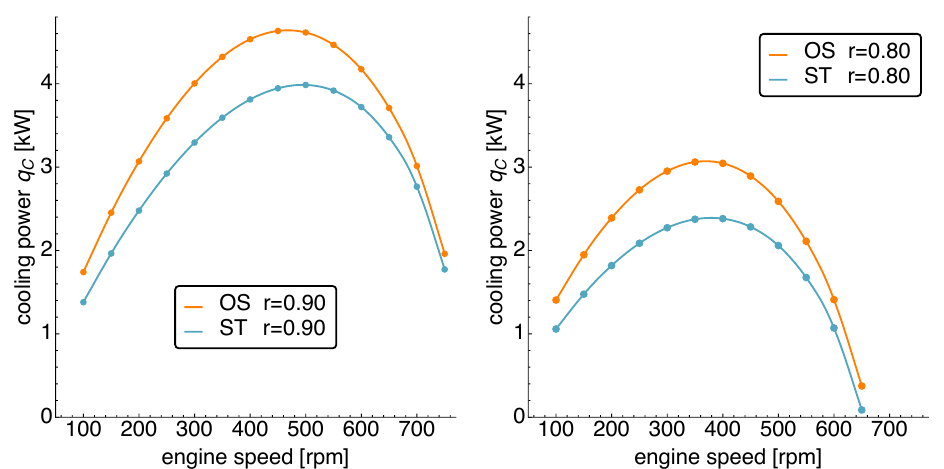
Figure 5. The cooling power q C vs. engine speed for OS and ST motion at different values of the regeneration coefficient ( left / right ). Comparing the cooling power for r = 0.9 ( left ) and r = 0.8 ( right ), it is apparent that the larger regeneration coefficient allows for a considerably higher cooling power. We also note that optimizing the piston motion (OS) causes a substantial increase in the cooling power, especially at intermediate speeds for both regeneration cases.